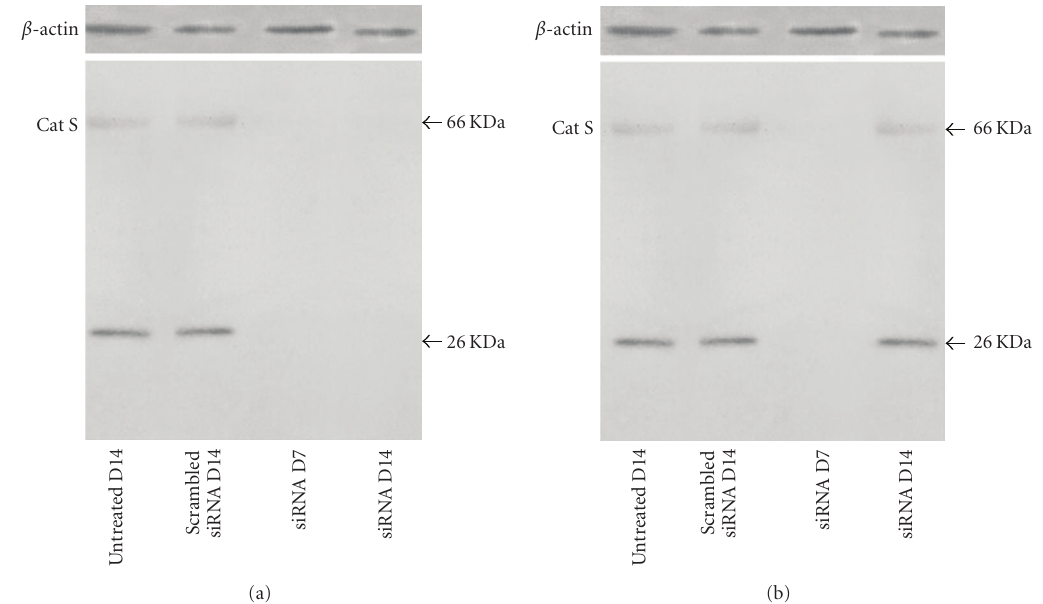
Figure 4: Silencing of cathepsin S during HSC di ff erentiation . (a) Levels of cathepsin S were assessed by Western blotting in dendritic cells generated from the di ff erentiation in vitro of HSCs. During the 14-day di ff erentiation process, cells were subjected to DOTAP-based transfection rounds on day 0, 3, and 9 using a CTSS-targeting siRNA as described in the Materials and Methods. Untreated and scrambled siRNA-transfected cells were employed for control purposes. Levels of precursor (66KDa) and mature (26KDa) forms of cathepsin S at di ff erent time points (i.e., days 7 and 14) are indicated. β -actin was used to normalize the signals. (b) Shown is the same analysis as in panel A, except for the number of transfections, that were performed on day 0 and 3 only. Graphs are representative of experiments consistently reproduced using at least 20 di ff erent populations of